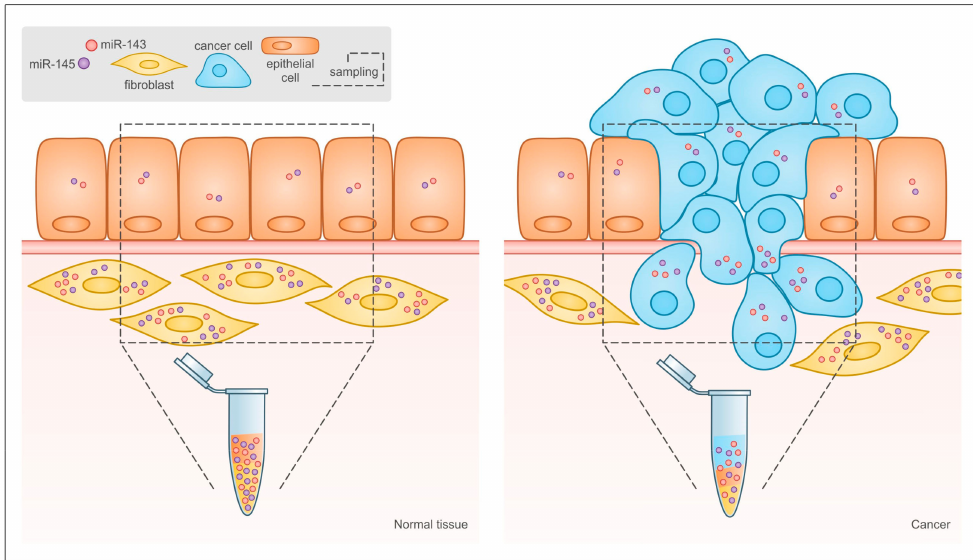
Figure 3. Relative abundance of di ff erent cell types in normal tissue and tumor may lead to misinterpretation of miR-143 and -145 expression data in solid tumors. In traditional bioptic samples, the amount of miR-143 and -145 that can be measured by RT-PCR is the result of their expression levels in the bulk of the tumor, including both cancer and stromal cells. As shown here, the expression of both microRNAs is much higher in stromal than in epithelial cells in normal tissues, and the relative abundance of the two cell types is inverted in tumors. This leads to reduced microRNA levels in the tumor bulk even when their expression is actually increased in tumor cells, and to the misleading conclusion that miR-143 and miR-145 are always down-regulated in